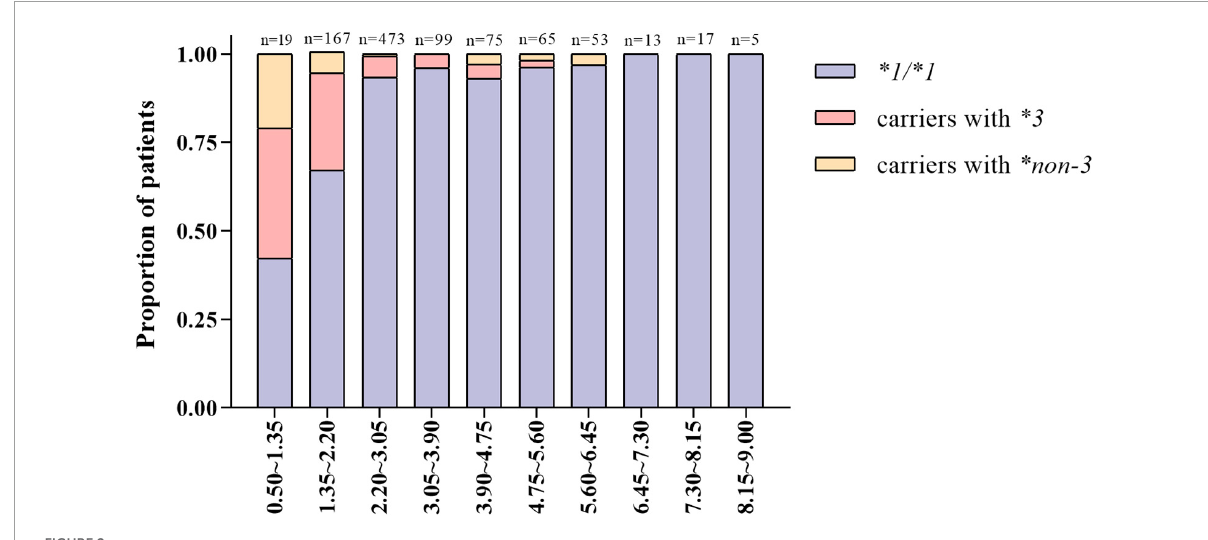
TABLE 5 Results of CYP2C9*3 and *non-3 variant association analysis (SKAT-O) with warfarin maintenance doses.